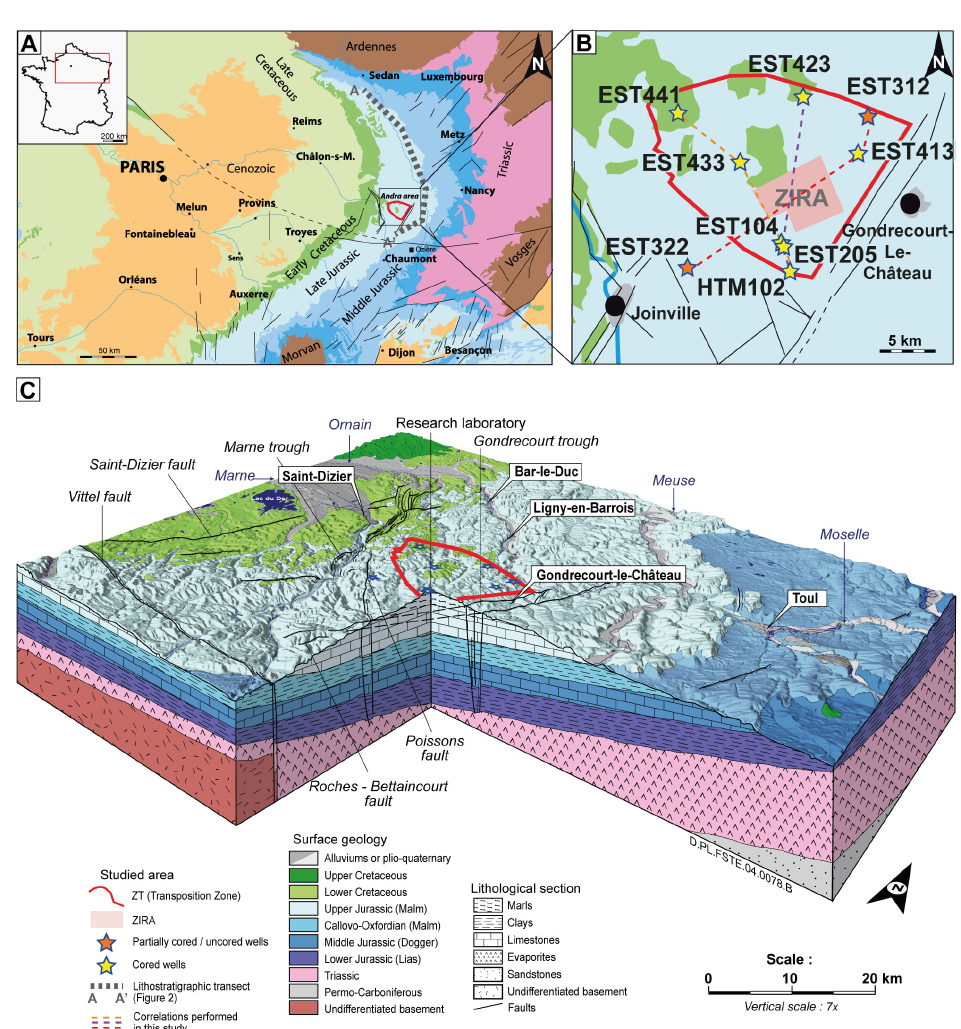
Figure 1. The studied area is located in NE France, in the northeastern part of the Paris Basin. ( A ) Geological map of the eastern part of the Paris Basin, the Zone of Transposition (ZT) is shown in red (modified after [6,30,32–34]); ( B ) Location of the ZIRA (area of interest for further research), in pink, targeted for future research, and location of the studied wells; ( C ) Geological model in 3D showing the structure of the basin.